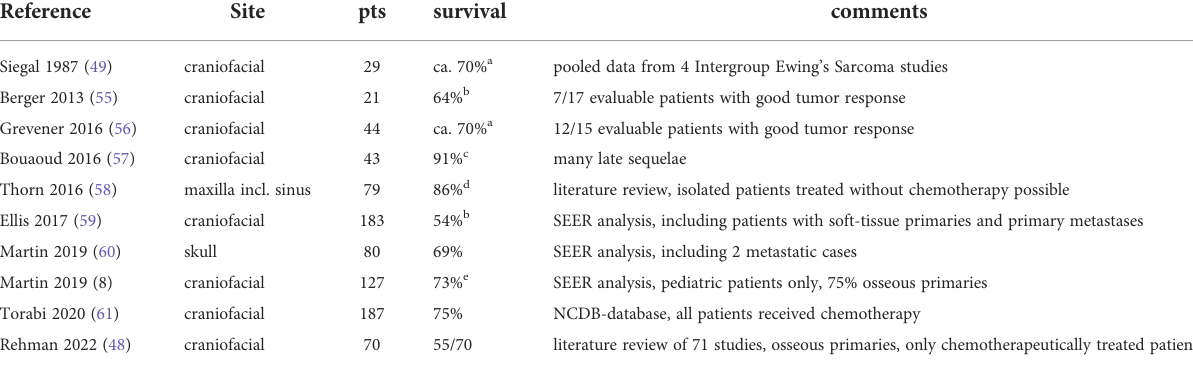
TABLE 2 Overview of multi-institutional analyses of chemotherapy in Ewing sarcoma of the head and neck.